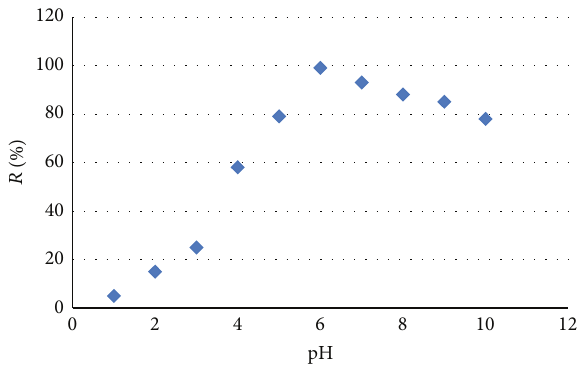
Figure 1: Effect of the sample pH on the preconcentration of arsenic from drinking water sample; experimental condition: 20 𝜇 g/L of arsenic, sample flow rate of 5 mL/min, and the eluent of HCl 0.1 M.